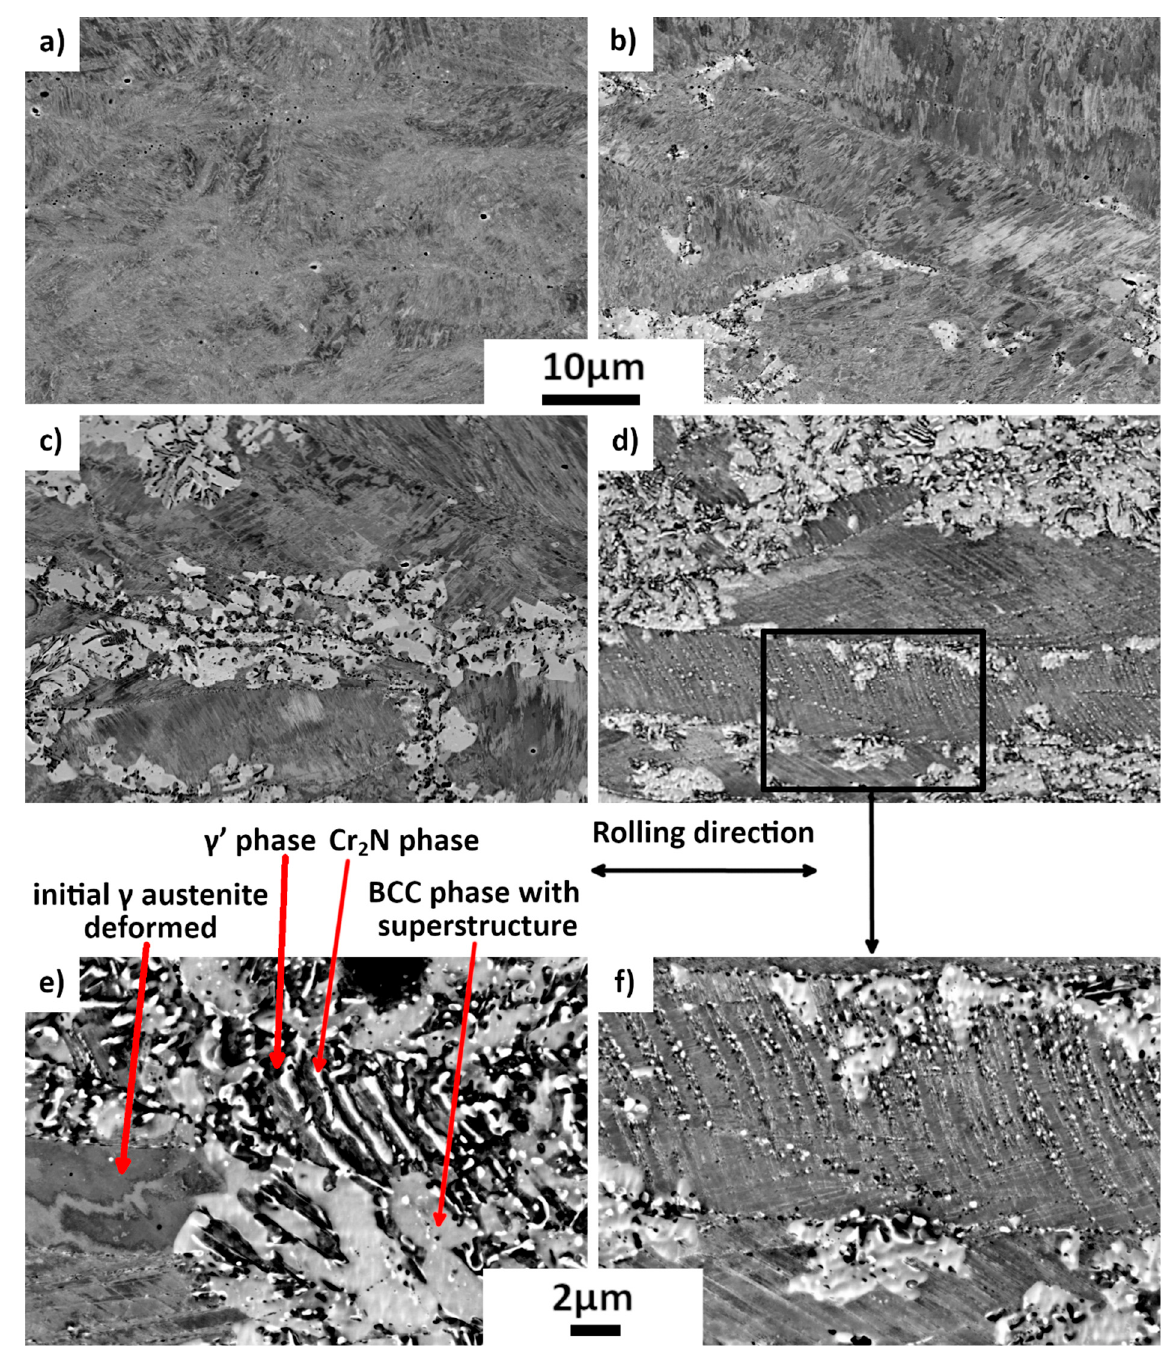
Figure 15. Evolution of microstructure with annealing times of 42%-rolled samples. SEM BSE mi- crographs. ( a ) 1 h; ( b ) 48 h; ( c ) 398 h; ( d ) 978 h; ( e ) and ( f ) magnified micrographs of 978 h-annealed samples. Cr 2 N precipitates may appear in white.